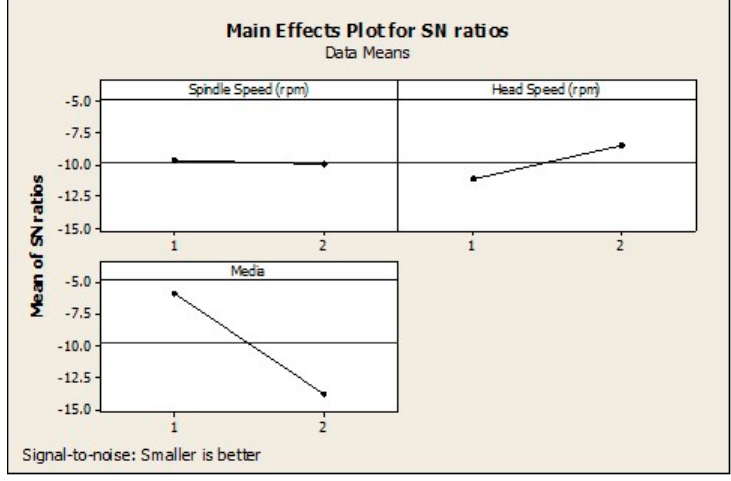
Figure 17. Effect of drag process parameters on surface roughness.